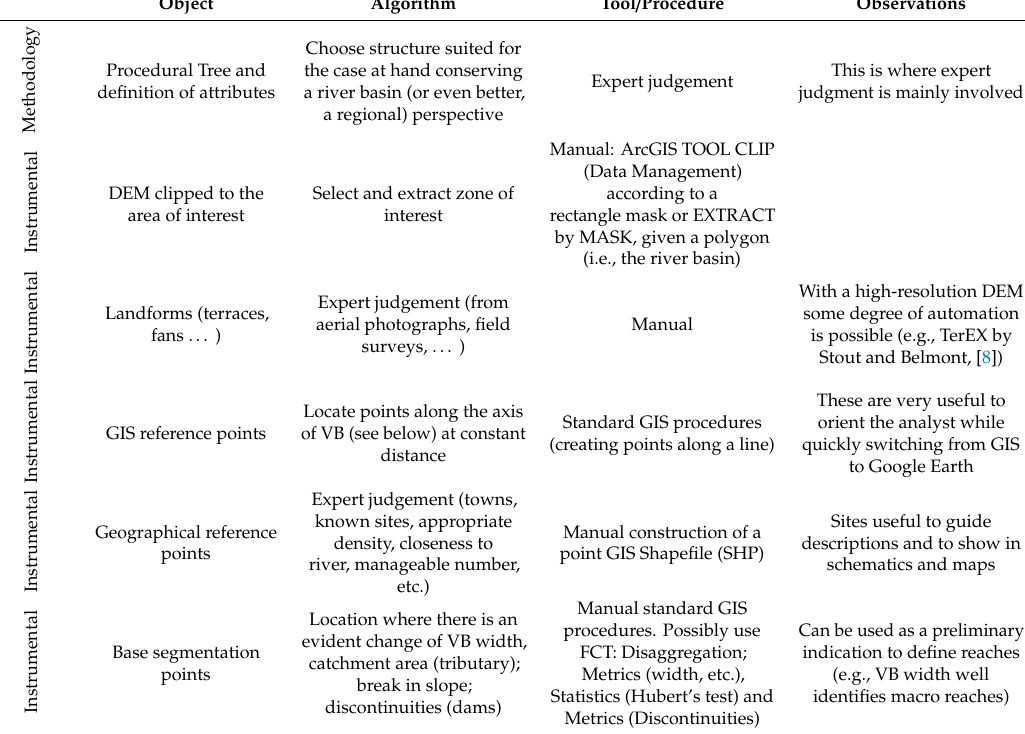
Table A1. Steps operationally needed to carry out a full River Styles (Stage I, Steps 1 and 2) analysis and corresponding tools / procedures proposed for doing so. Bold italic type items are those we developed “ex-novo” and which are fully described in the ToolBox Manual; two of these—“Confinement tool” and “Reductionist → Holistic algorithm”—have been described in the text above (Section 3.1). Notice that in our application to the Magdalena River Basin, described in [16,17], we adopted a set of o ffi cial digital ArcGIS shapefiles that allowed us to skip some of the steps related to the delineation of geomorphic elements and units (but not all), but at the same time raised some issues mainly due to resolution and lack of synchronicity with the available Digital Elevation Model (DEM) from the Shuttle Radar Topography Mission (SRTM) 30 m